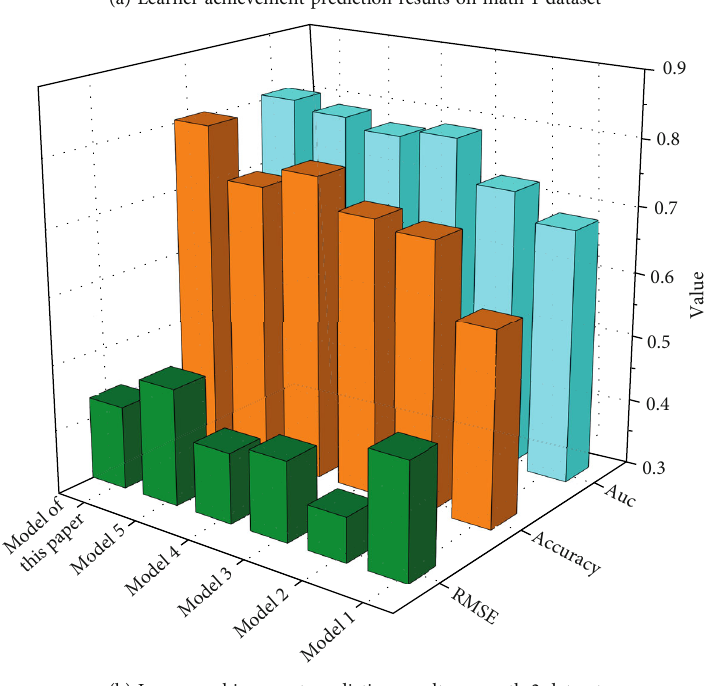
Figure 4: Prediction results of learners ’ performance in di ff erent